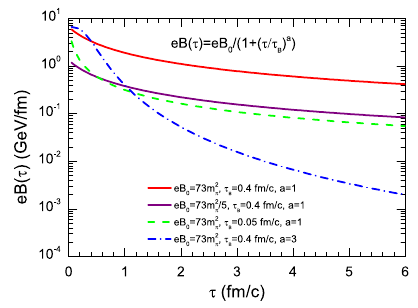
Figure 1. (Color online) The time dependence of eB ( τ ) with di ff erent parameter sets of eB 0 , τ B and a .